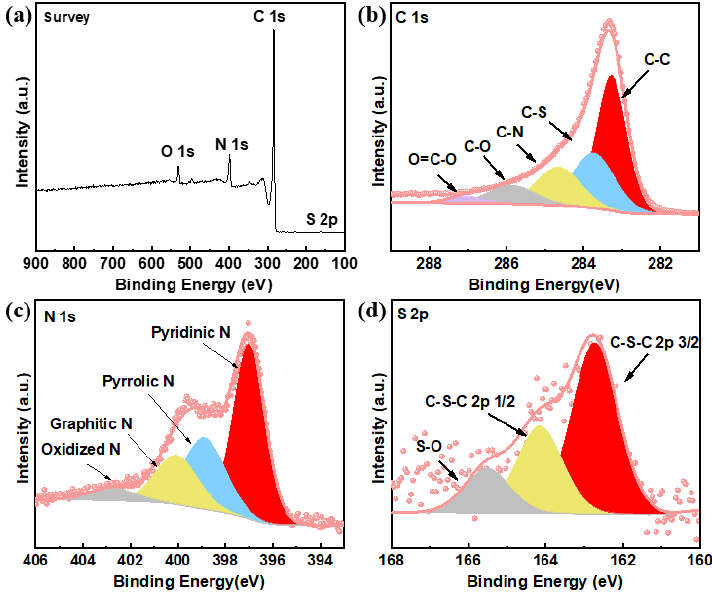
Figure 2. ( a ) The XPS survey, ( b ) C 1s, ( c ) N 1s and ( d ) S 2p spectra of N, S-GNR-2s. The D band (located at ~1360 cm − 1 ) and G band (located at ~1580 cm − 1 ) are shown in the Raman spectra of N-GNRs, N, S-GNRs and N, S-GNR-2s (Figure 3). The I D /I G ratio of N-GNRs was calculated to be 1.28, owing to N-doping and the formation of the porous structure caused by the release of gas generated during the thermal decomposition of urea. Compared with the N-GNRs, both the N, S-GNRs and N, S-GNR-2s had more defects caused by additional S-doping. As a result, the I D /I G ratios of the N, S-GNRs and N, S-GNR-2s were increased to 1.36 and 1.37, respectively [46].